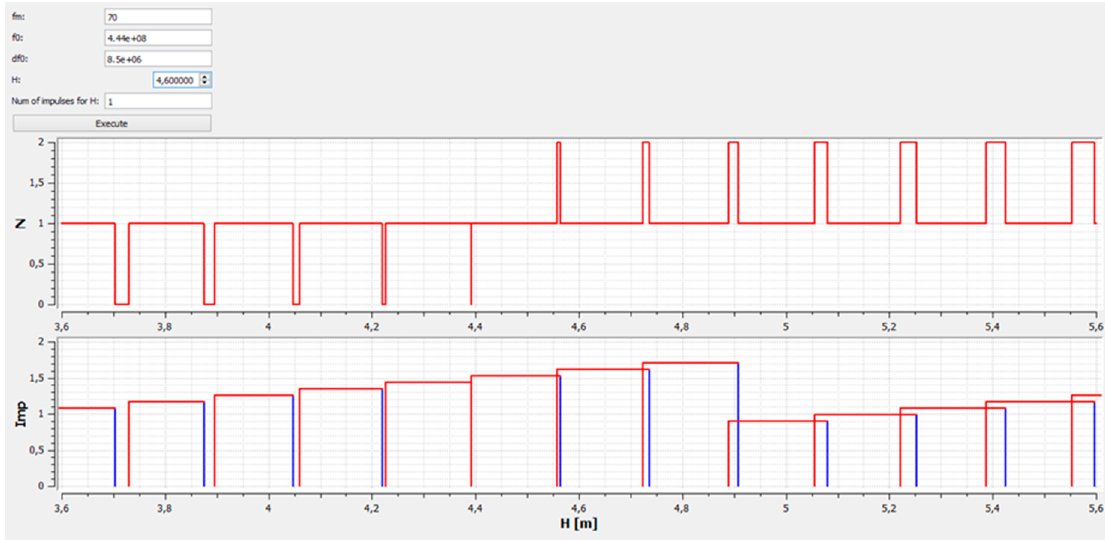
Figure 8. An example of the software application for simulating the unstable pulses creation.